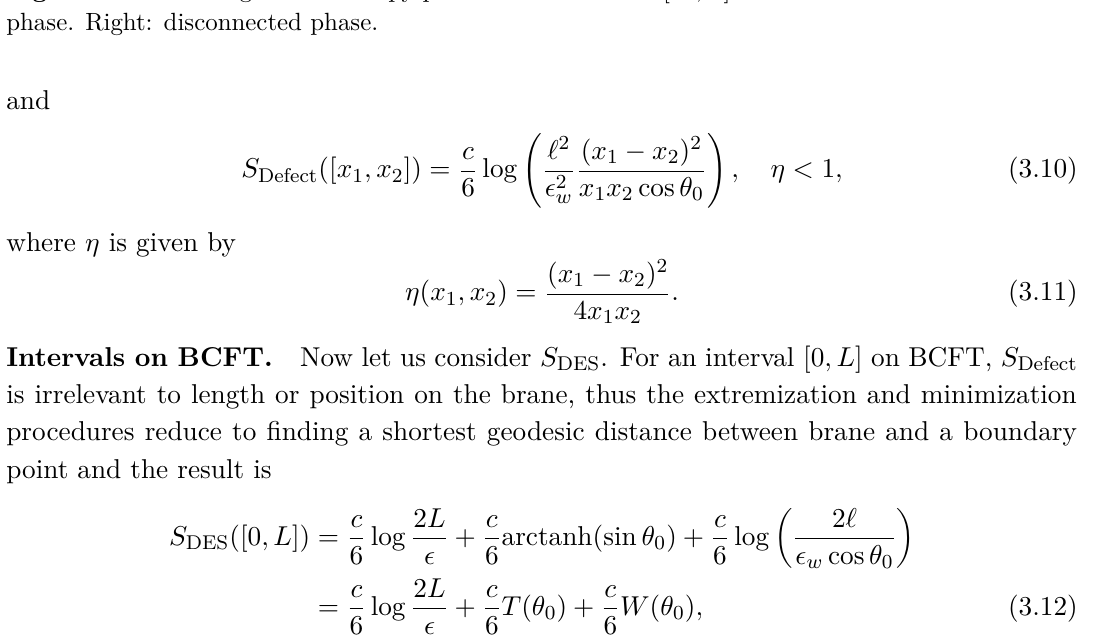
Figure 3 . The entanglement entropy phases for an interval [ M, L ] in DES model. Left: connected phase. Right: disconnected